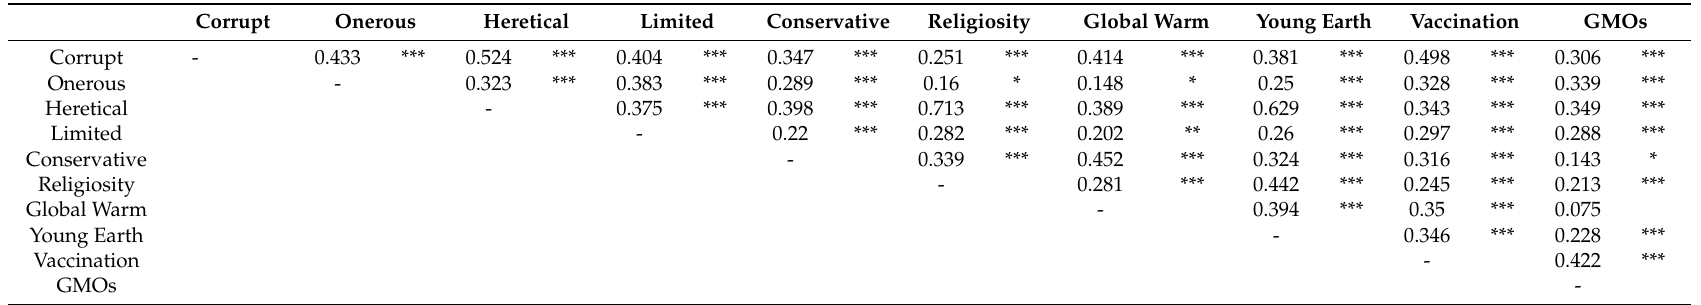
Table 3. Correlations among study